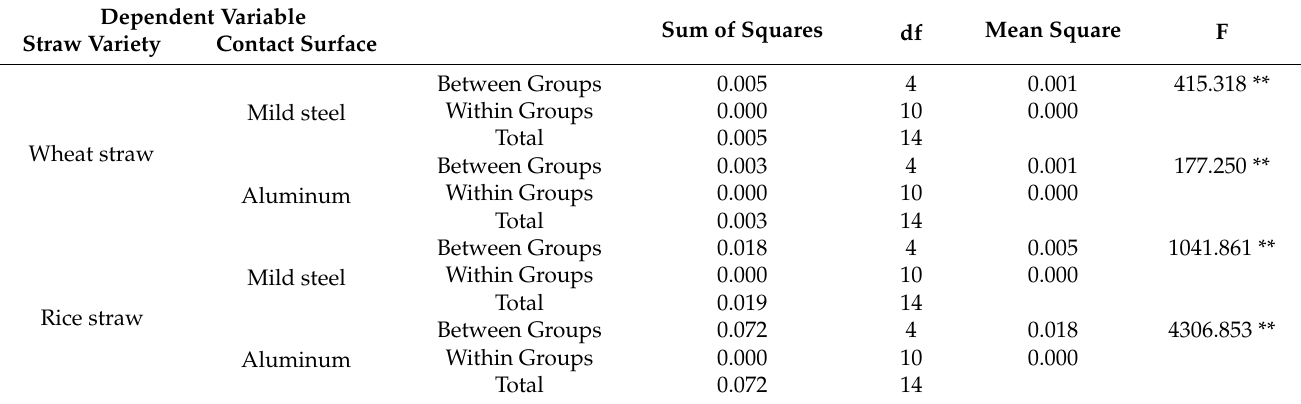
Table 5. The ANOVA results for the coefficient of sliding friction regarding